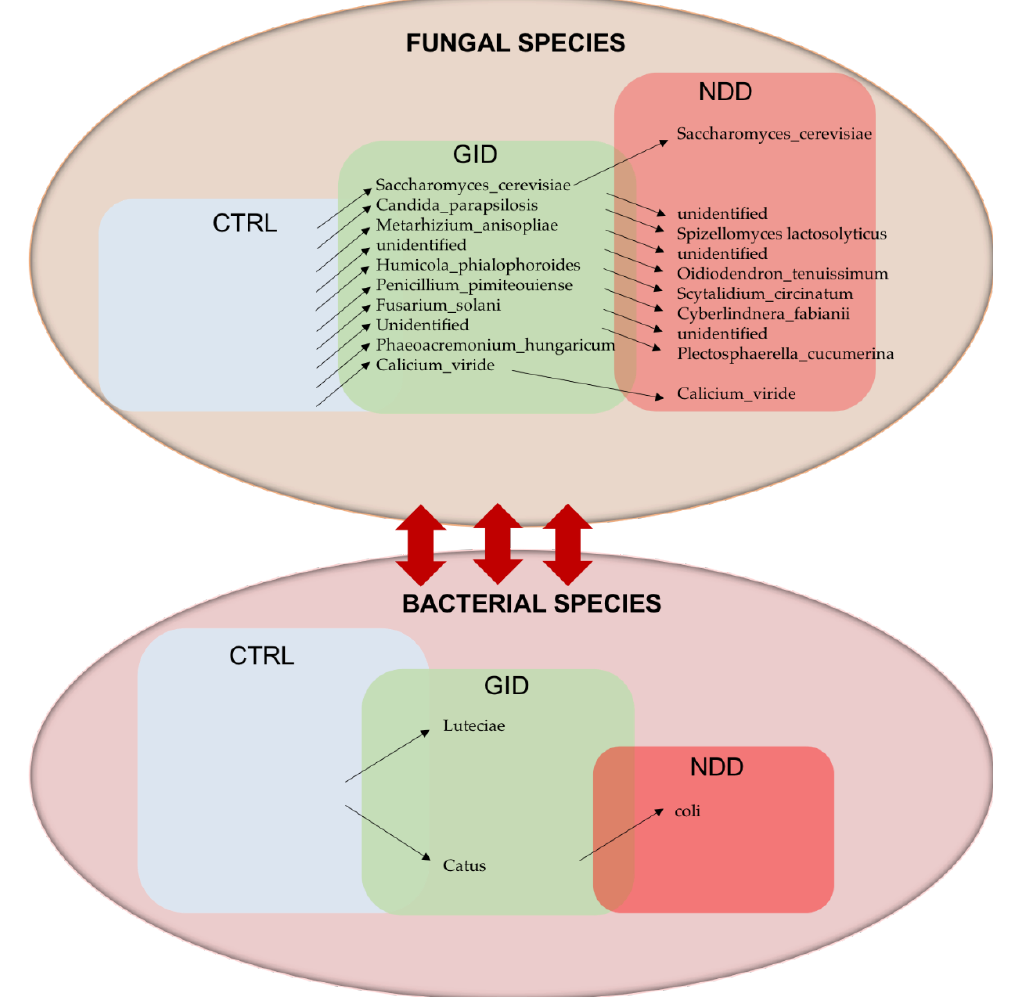
Figure 4. Fungal species as key players in GID and NDD. Arrows up show the increasing abundance of species, and arrows down show the decreasing abundance of species between two consecutive boxes. Height of the boxes CTRL, GID and NDD simulates the increasing alpha diversity for fungi and the decreasing alpha diversity for bacteria. The double arrow shows the interaction between bacteria and fungi.